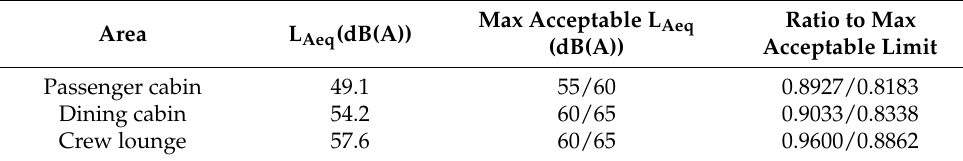
Table 4. A-weighted noise levels in different measurement areas.